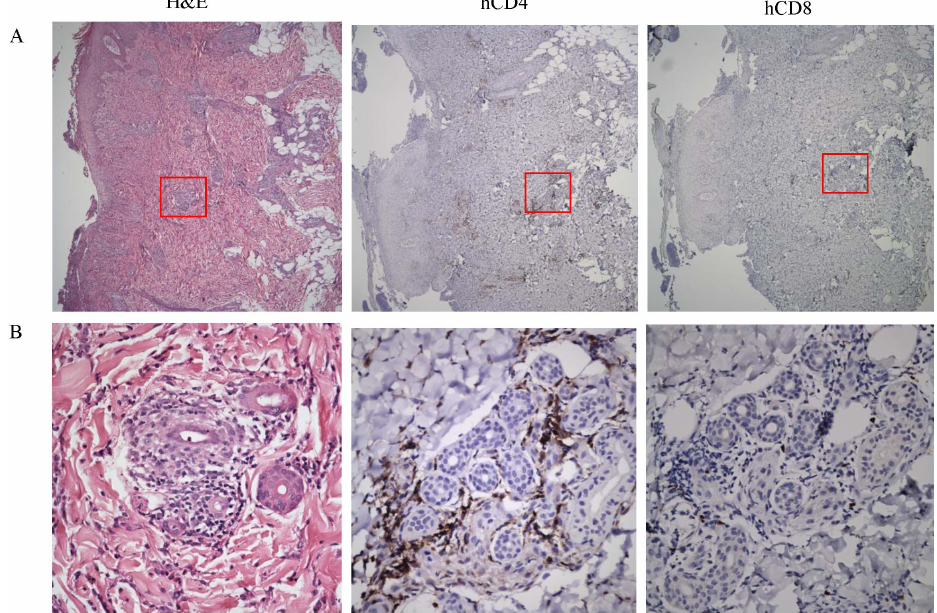
Figure 2. Histologic features of skin lesions in a patient with delayed-type midge allergy. Skin biopsy was performed within 48 hours after midge bites and the sections were stained with hematoxylin and eosin stain (H&E) or immuno-stained with anti-human CD4 (hCD4) or CD8 (hCD8) monoclonal antibodies. Magnification: A, 6 50; B, 6 400. doi:10.1371/journal.pone.0091871.g002 PLOS ONE |